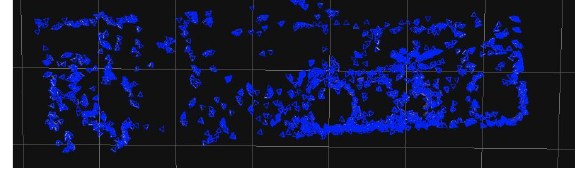
Figure 1. Oriented cameras viewed overhead